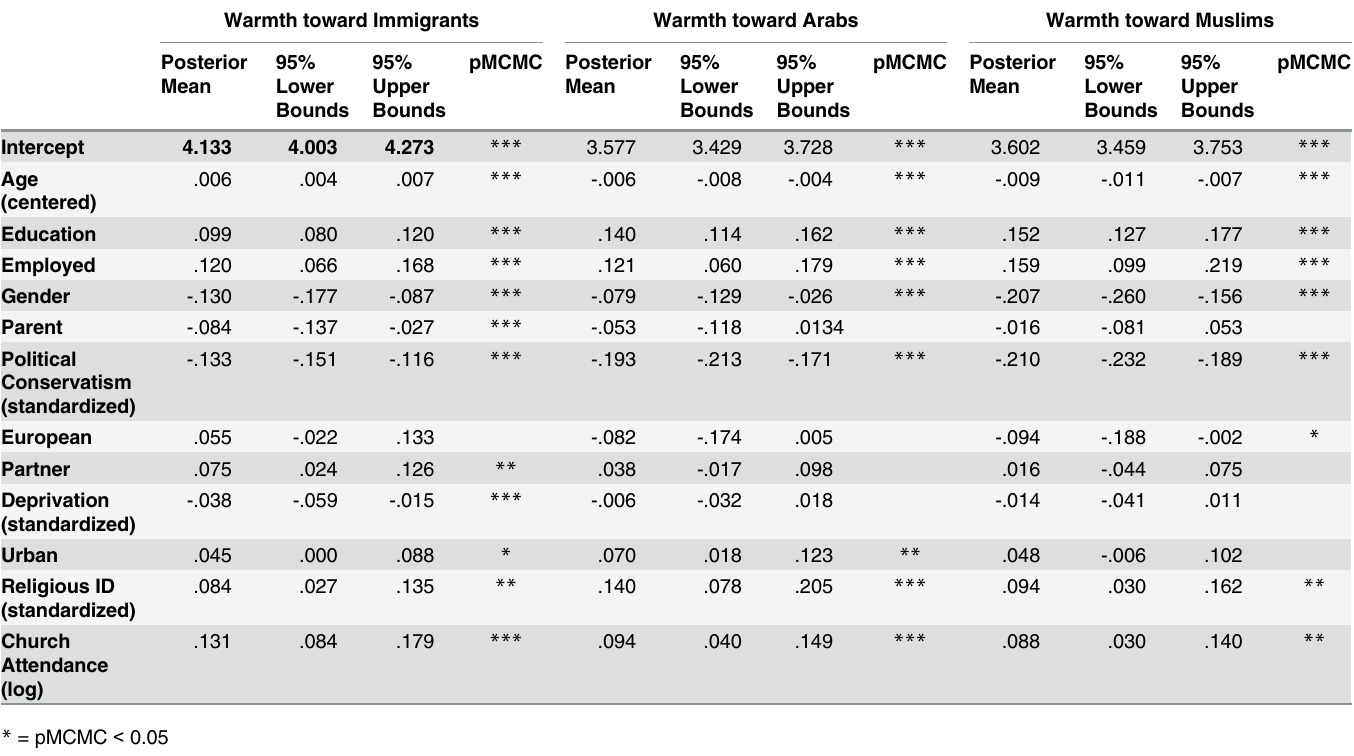
Table 3. Predictors of Tolerance toward Immigrants, Arabs and Muslims. Warmth toward